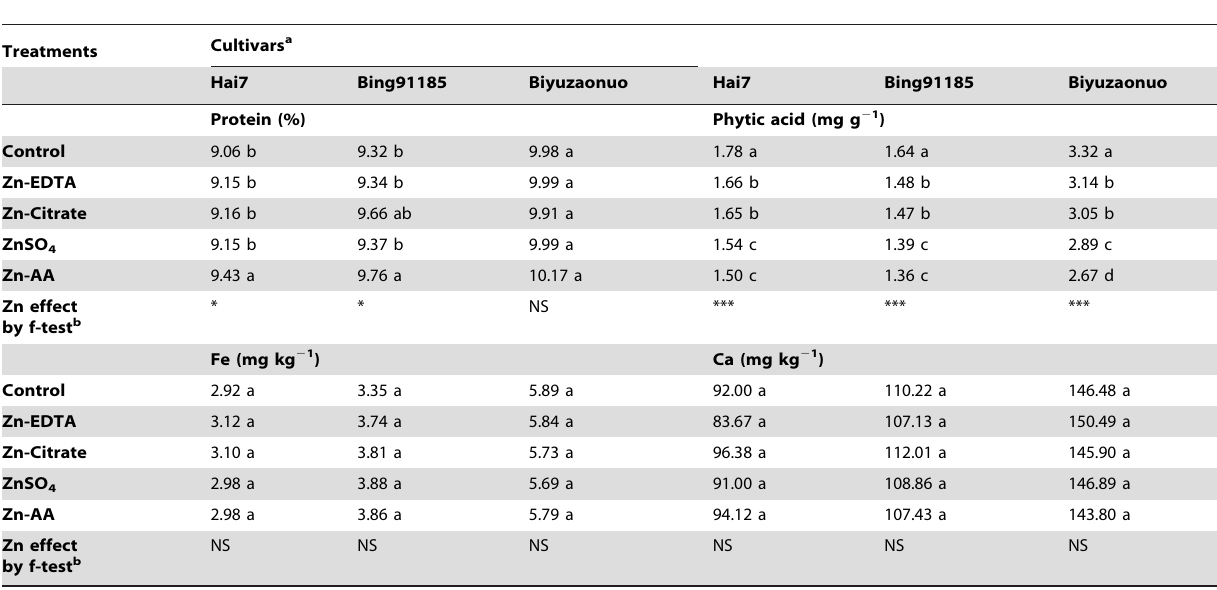
Table 3. Effect of different forms of foliar Zn fertilization on the grain protein, phytic acid, Fe and Ca contents of three rice